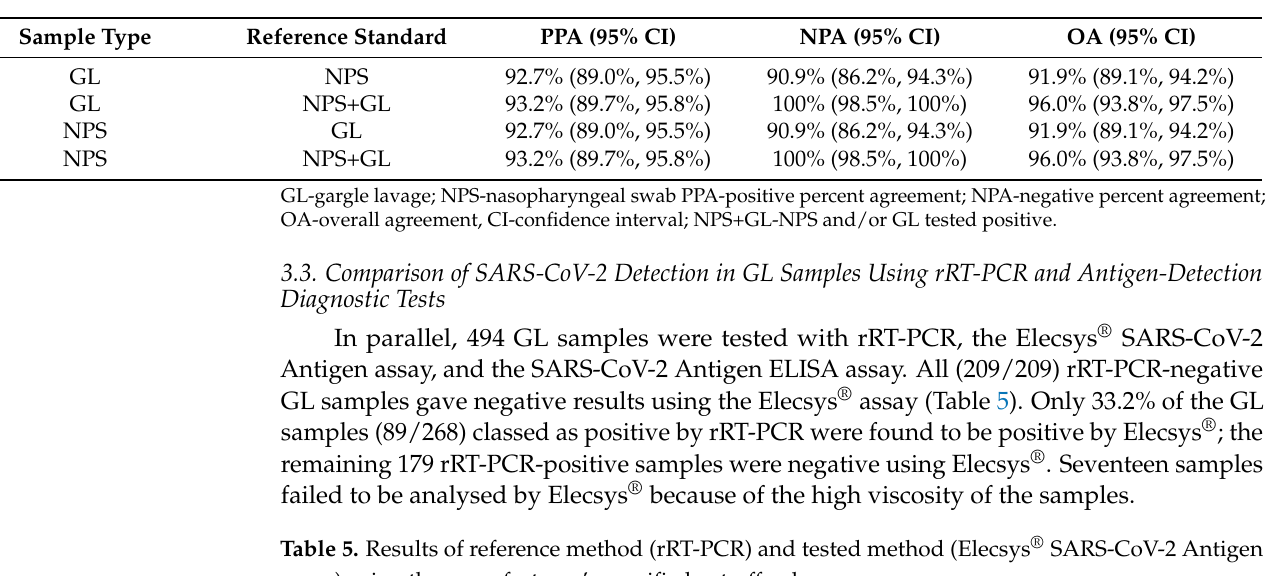
Table 4. Performance characteristics of SARS-CoV-2 rRT-PCR detection in nasopharyngeal swab and gargle lavage samples using different reference standards.